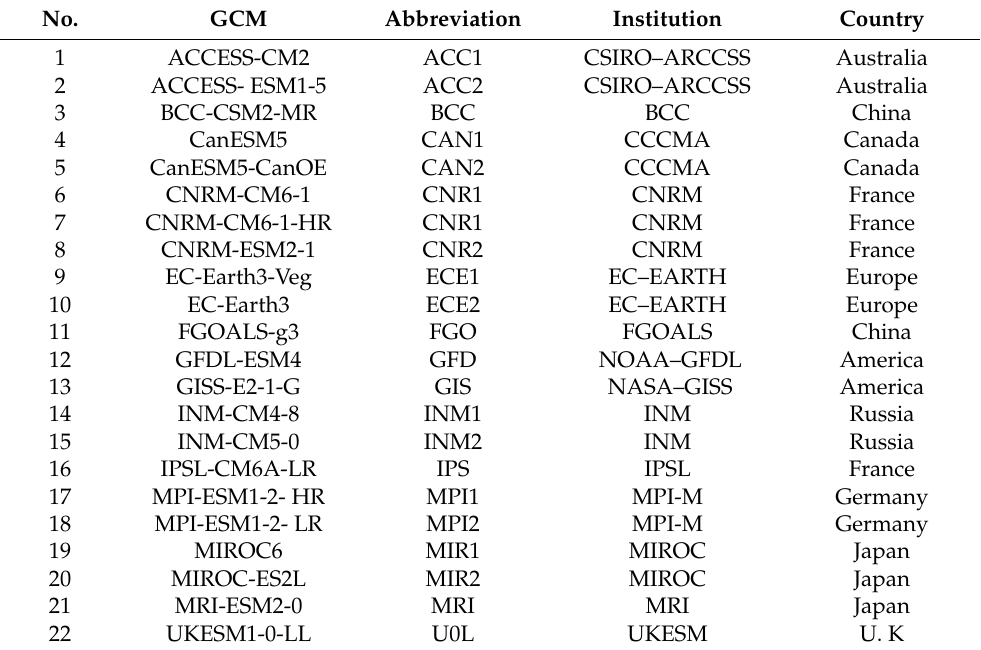
Table 4. List of 22 global climate models (GCMs) used in this study. No.